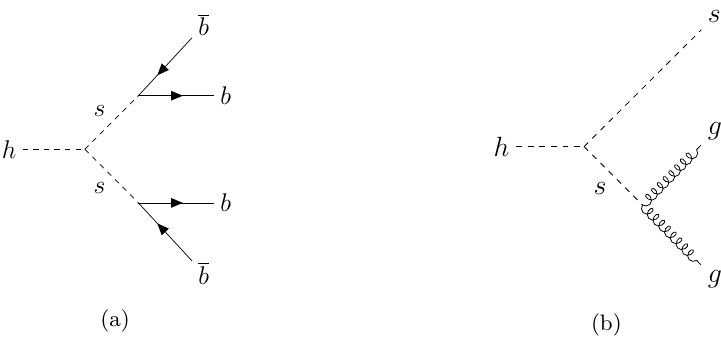
Figure 5 . Possible exotic Higgs boson decays with sgoldstino